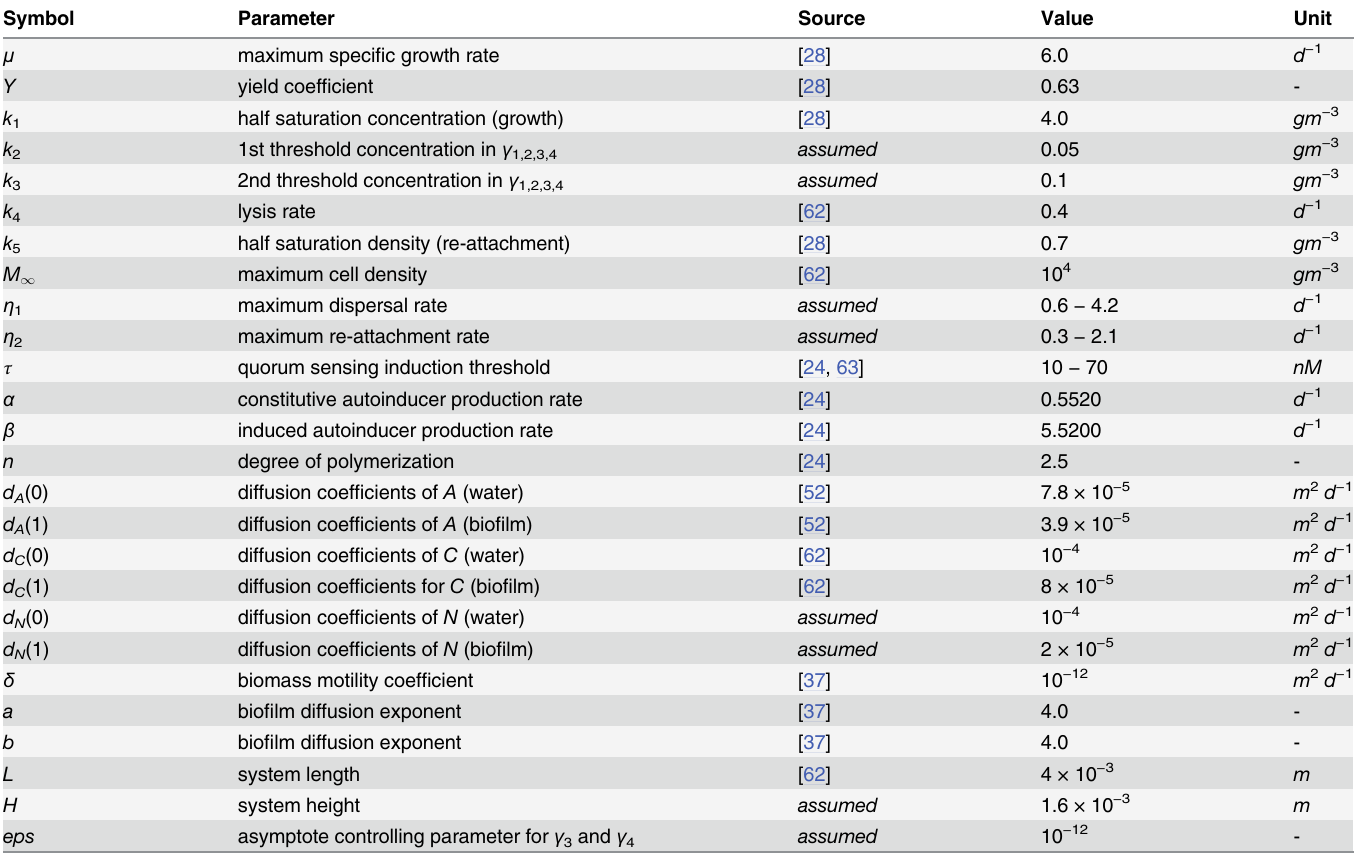
Table 1. Parameter values used in the numerical